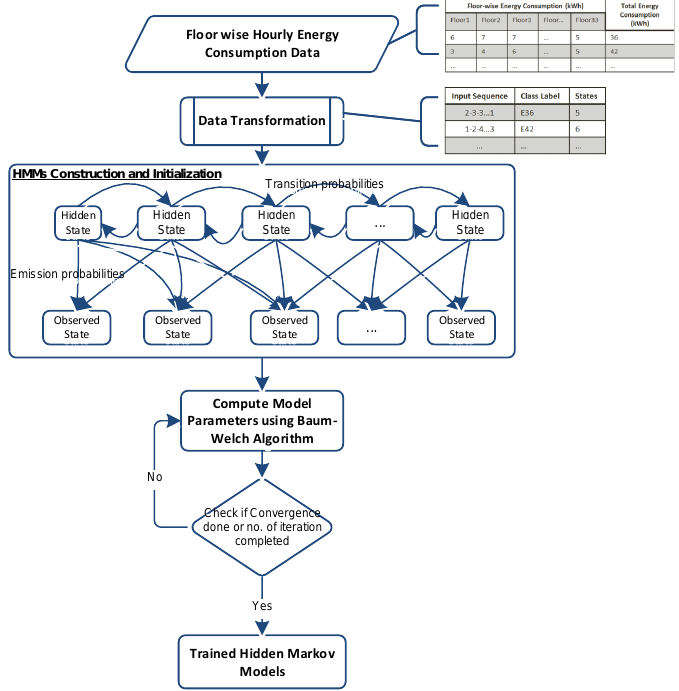
Figure 3. Flowchart of HMMs construction, initialization and training.